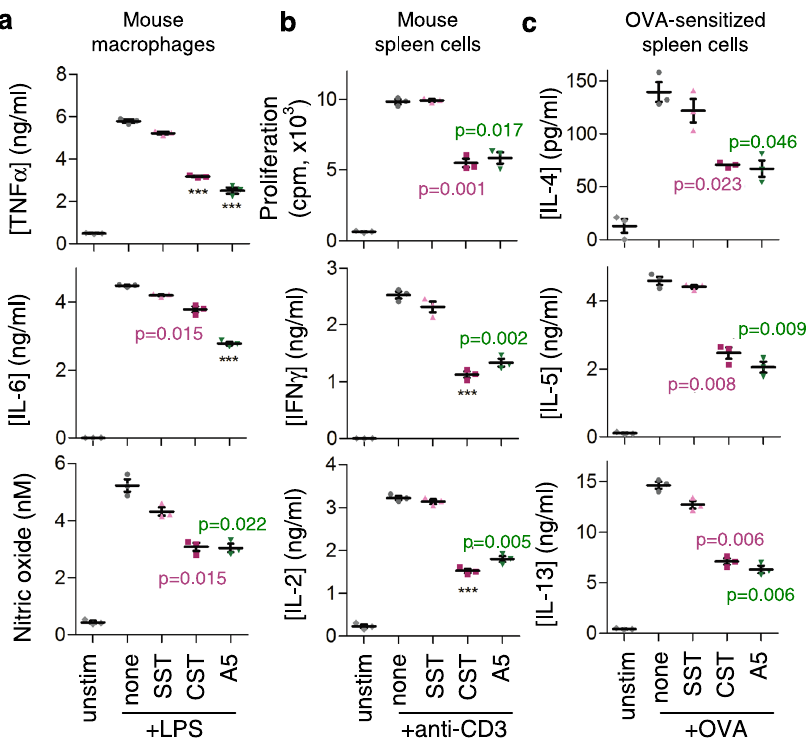
Fig. 2 Cortistatin analogue 5 regulates macrophage and lymphocyte activation. Effects of Somatostatin (SST), Cortistatin (CST) and analogue 5 (A5) on the production of in fl ammatory cytokines and nitric oxide by LPS-activated mouse Raw 264 macrophages ( a ), on cell proliferation and production of Th1- type cytokines by anti-CD3-activated mouse spleen cells ( b ) and on the production of Th2-type cytokines by OVA-activated spleen cells isolated from mice immunised with OVA ( c ). Peptides were used at 100 nM and the dose-response curve for analogue 5 and cortistatin are shown in Supplementary Fig. 2a, b. Cells cultured in medium alone were used as unstimulated controls. Data are the mean ± SEM with dots representing individual values of biologically independent cell cultures, each performed in duplicate. Statistical signi fi cance between groups was assessed by paired, two-tailed Student ’ s t test. *** p < 0.001, **** p < 0.0001 vs. stimulated cells in the absence of peptides. Exact p -values are shown for p > 0.001. Source data are provided as a Source Data fi